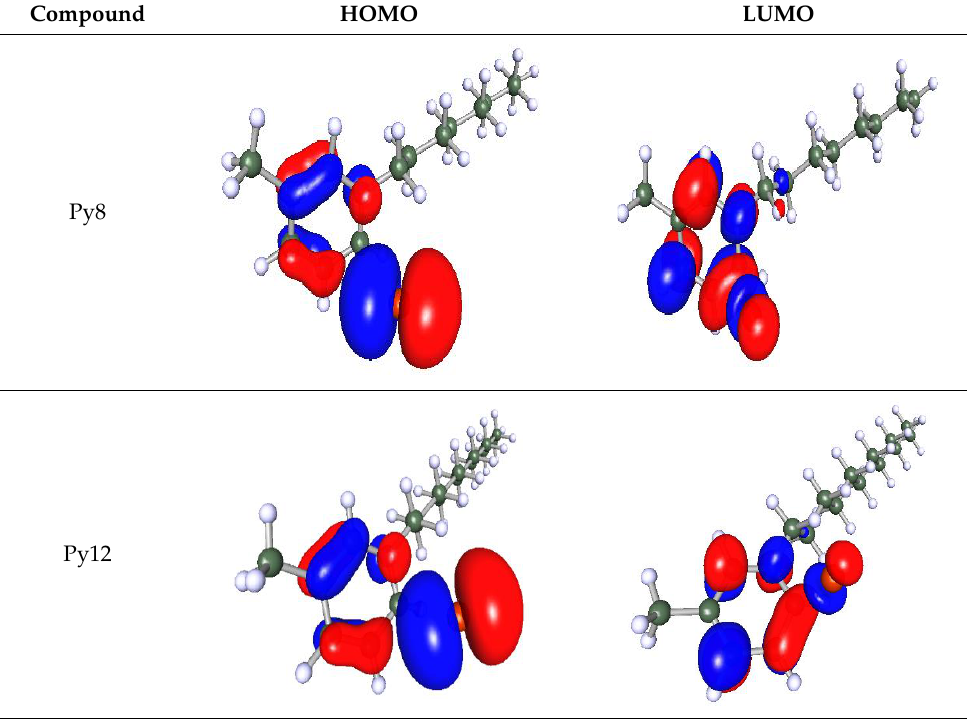
Table 8. Computed energy values of FMOs and reactivity descriptors of pyridinium based surfactants Py8 and Py12 at DFT/PBE/def2-TZVPP basis set in vacuum.